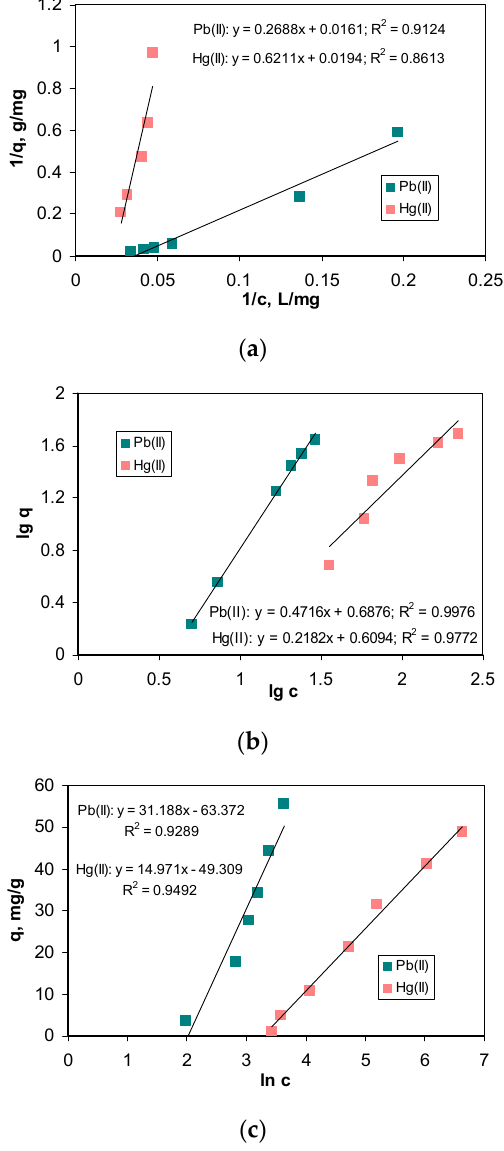
Figure 5. Linear representations of Langmuir model ( a ), Freundlich model ( b ) and Temkin model ( c ) for the biosorption of Pb(II) and Hg(II) ions onto RWB.